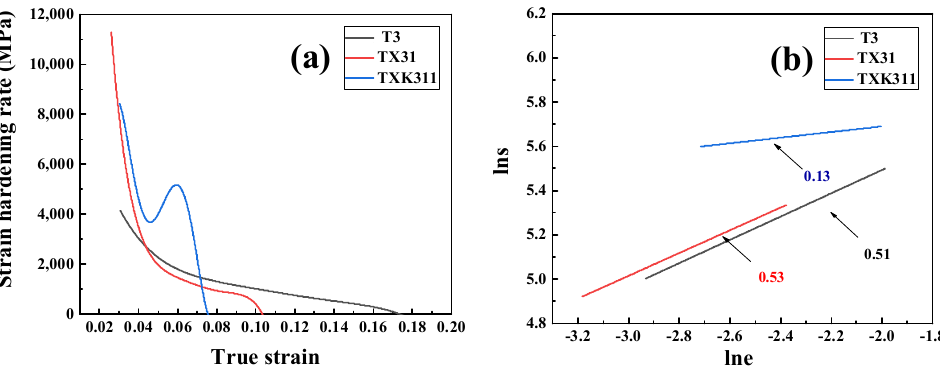
Figure 10. Strain hardening rate ( a ) and strain hardening index ( b ) of three as-extruded alloys.